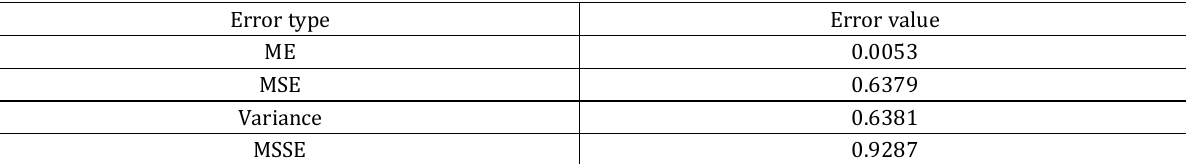
Table 8. Error values received as a result of using cross-validation based on repeatedly performed variogram setups (error indications are explained in main